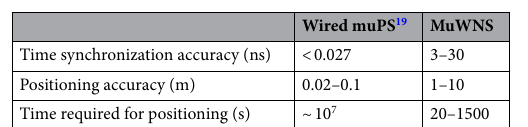
Table 1. Comparison between the wired muPS 19 and the current